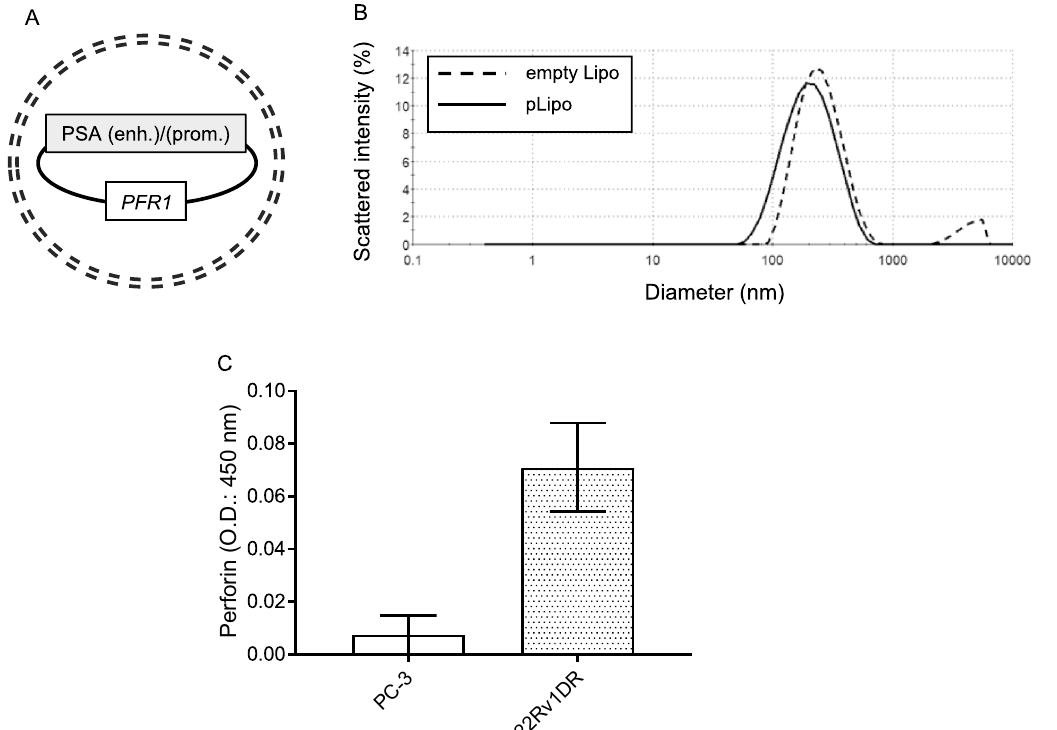
Figure 3. Characteristics of liposomes encapsulating PSA promoter-driven perforin expression vector. ( A ) A schema of liposomes encapsulating PSA promoter-driven perforin expression vector (pLipo). ( B ) The diameter of empty Lipo and pLipo were measured using a particle size analyzer. ( C ) PC-3 and 22Rv1DR cells (2.0 × 10 4 ) were seeded on a 96-well plate and pLipo containing 0.5 μg of perforin expression vector were added to each well. Forty-eight h after treatment, the perforin expression level in conditioned medium was measured by ELISA. Data shown are mean with SD (n = 3 in each